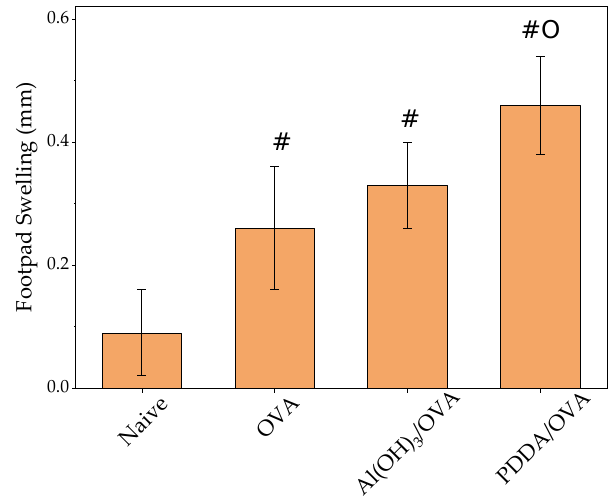
Figure 8. Mean footpad swelling ± standard deviation related to delayed-type hypersensitivity reaction of BALB / c mice immunized with OVA, Al(OH) 3 / OVA, or PDDA / OVA NPs at concentrations given on Table 1. p < 0.05 compared to naive group (#), p < 0.05 compared to OVA group (o).